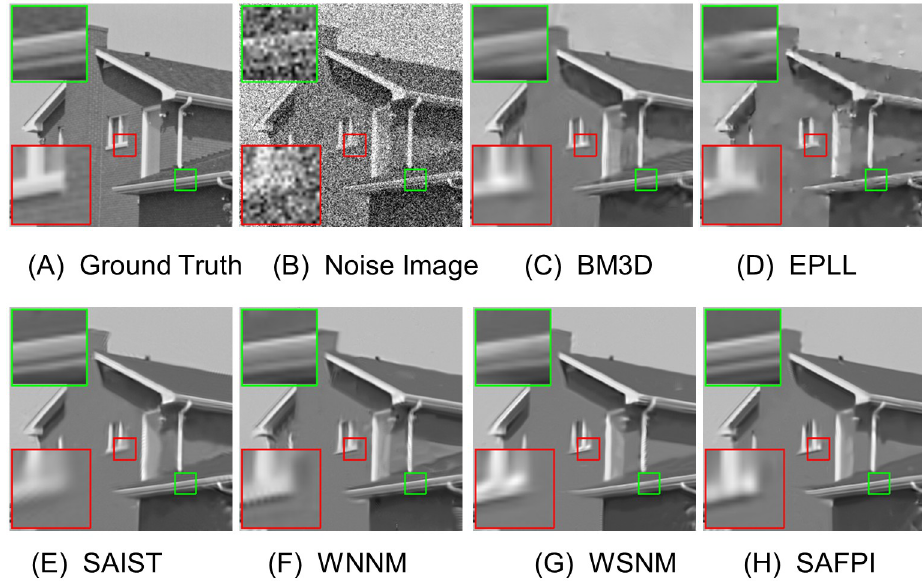
Fig 6. Denoising results on image House by different methods (noise level σ n = 50). (A) Ground Truth(B) Noisy Image (C) BM3D, PSNR = 29.69 (D) EPLL, PSNR = 28.76 (E) SAIST, PSNR = 29.99 (F) WNNM, PSNR = 30.28 (G) WSNM, PSNR = 30.21 (H) SAFPI, PSNR =